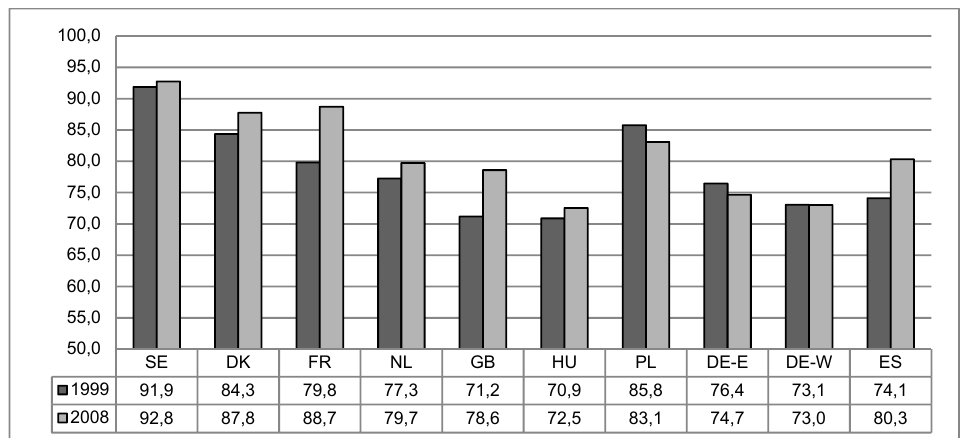
Figure 1 : Percentage of respondents who agree to the statement that the father as well suited to look after children as mothers (weights